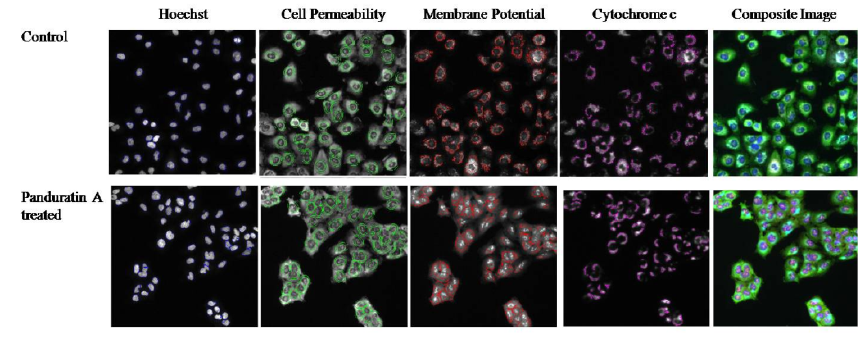
Figure 6. Representative images of A549 cells treated with medium alone and 5 µg/mL of panduratin A, all at 20X, and stained with Hoechst for nuclear, cell permeability dye, mitochondrial membrane potential dye and cytochrome c. The images from each row are obtained from the same field of the same treatment sample. A549 produced a marked reduction in nuclear area, mitochondrial membrane potential, and marked increases in membrane permeability. Circular outlines indicate the areas within cells in which fluorescence intensity is